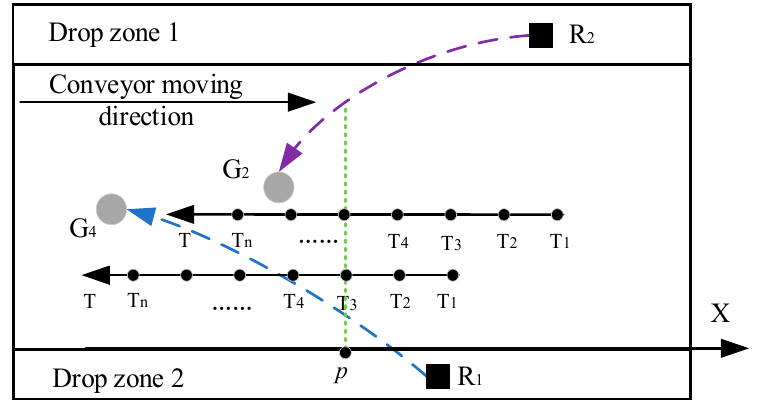
Figure 10. Sorting trajectory diagram 1 of the robot arm after trajectory coordination.